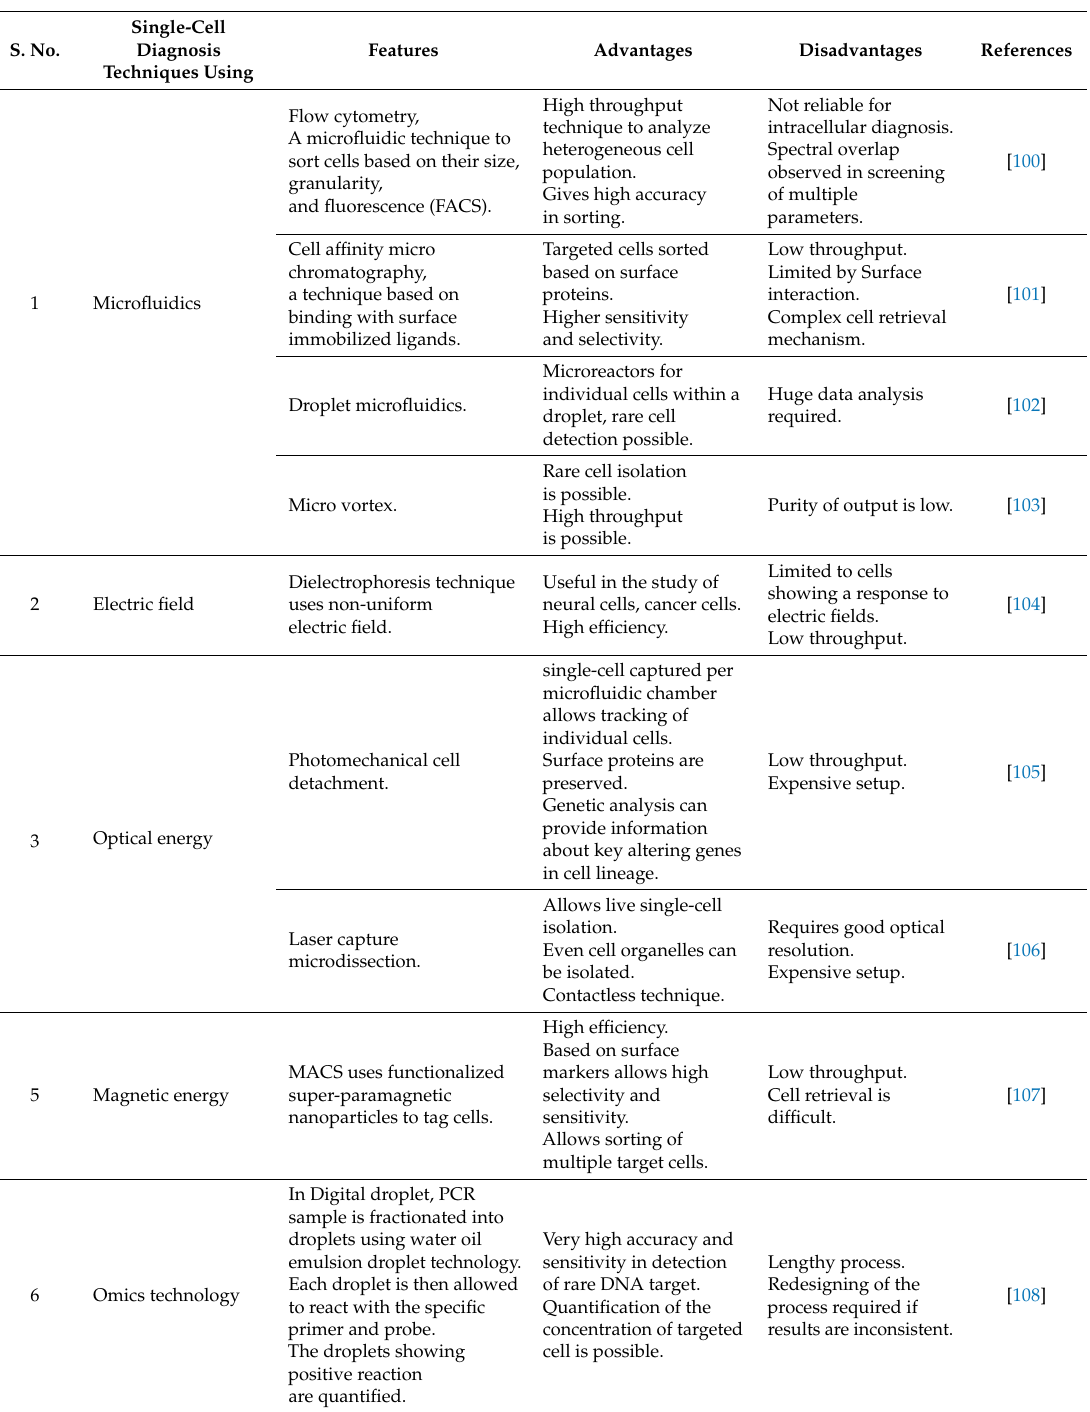
Table 2. Single-cell diagnosis